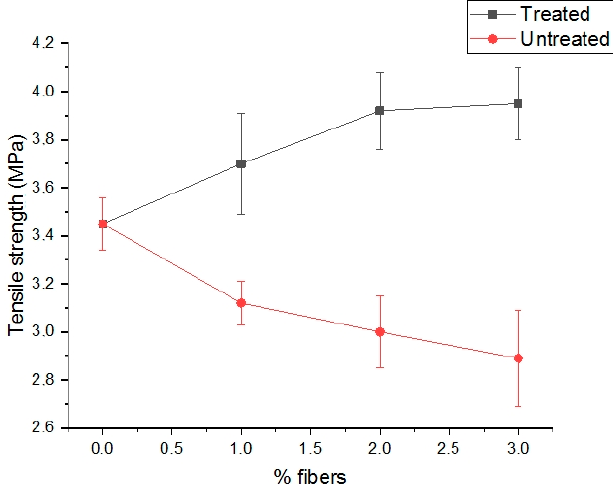
Figure 2. Tensile strength of mortars.